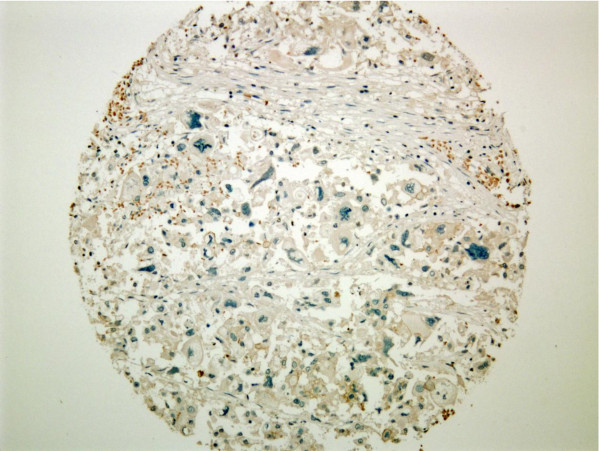
TMA core displaying completely negative staining for HER2 (4B5 antibody). HER2, human epidermal growth factor receptor 2; TMA, tissue micro-array.